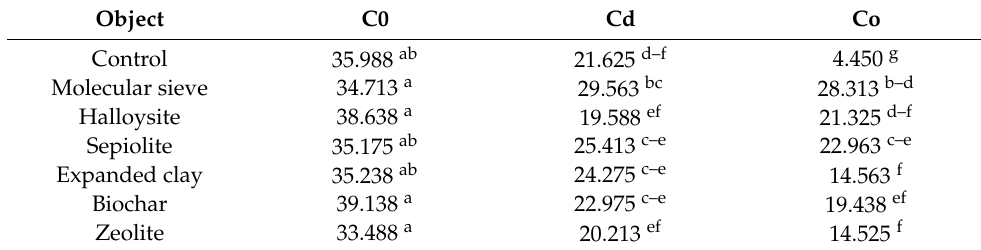
Table 2. Greenness index